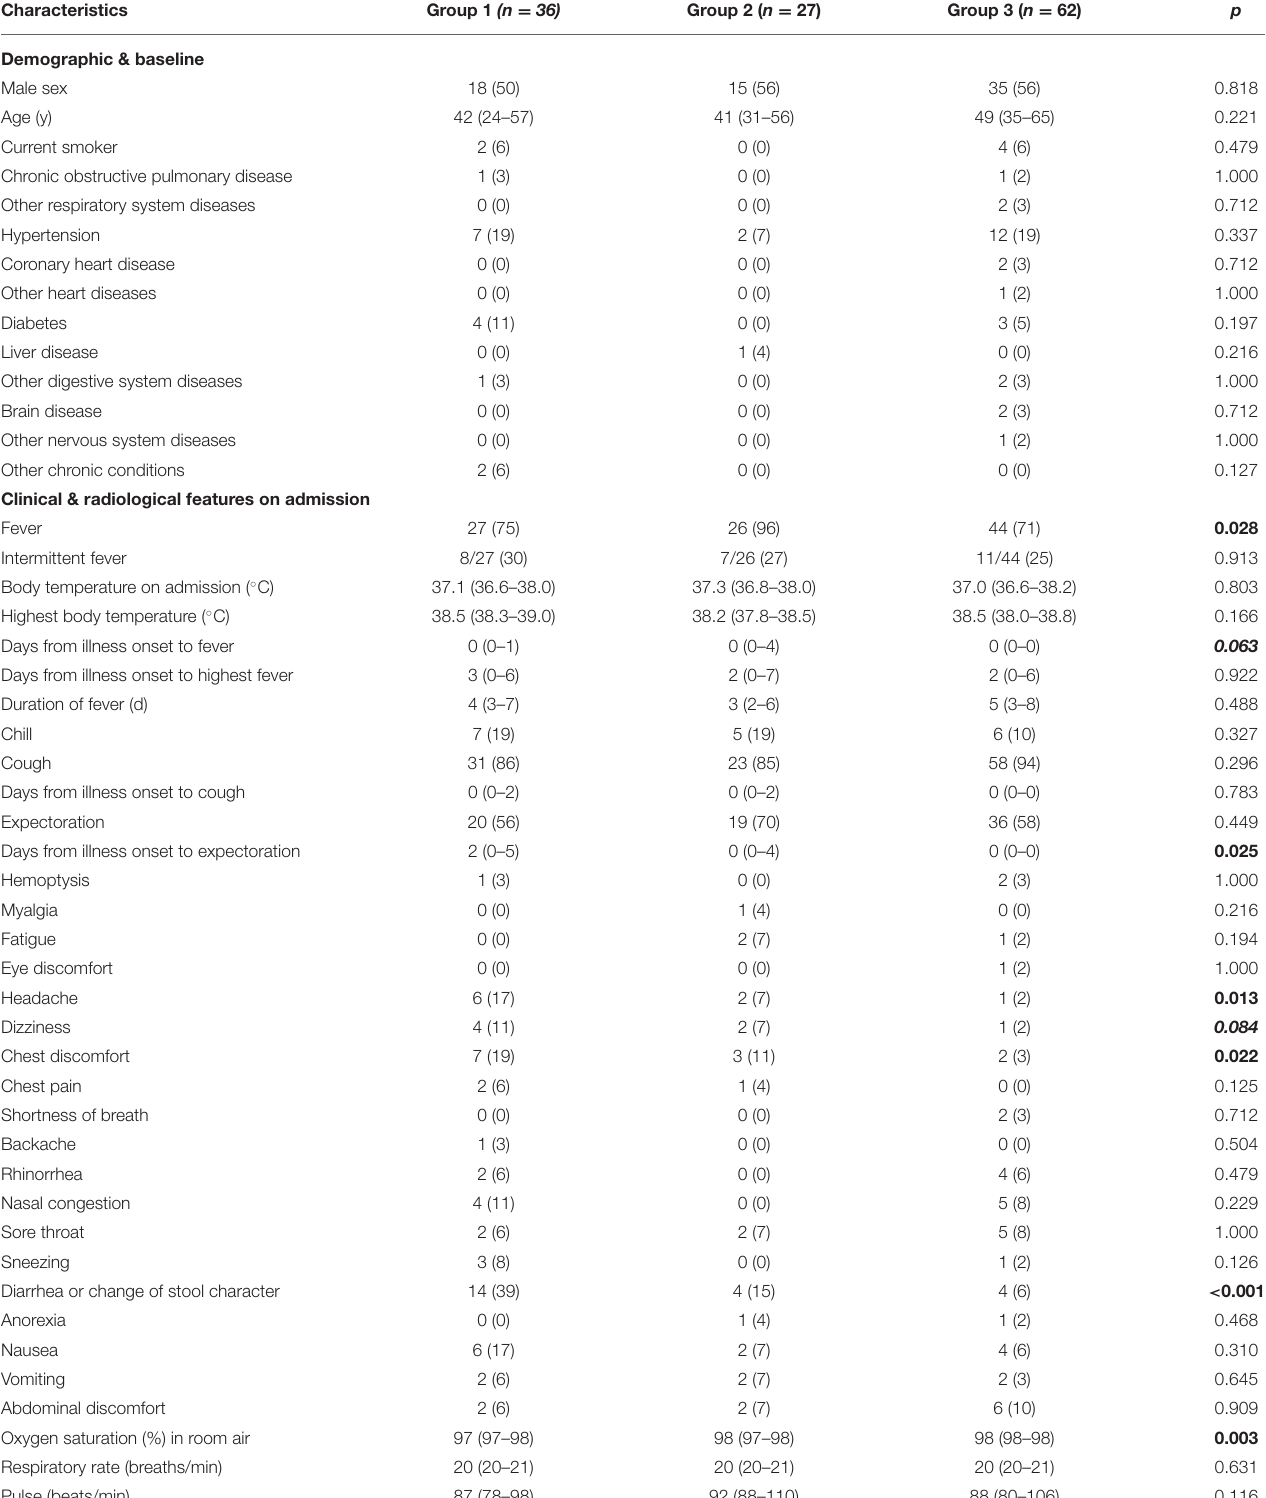
TABLE 1 | Demographic, baseline, clinical, and radiological features.